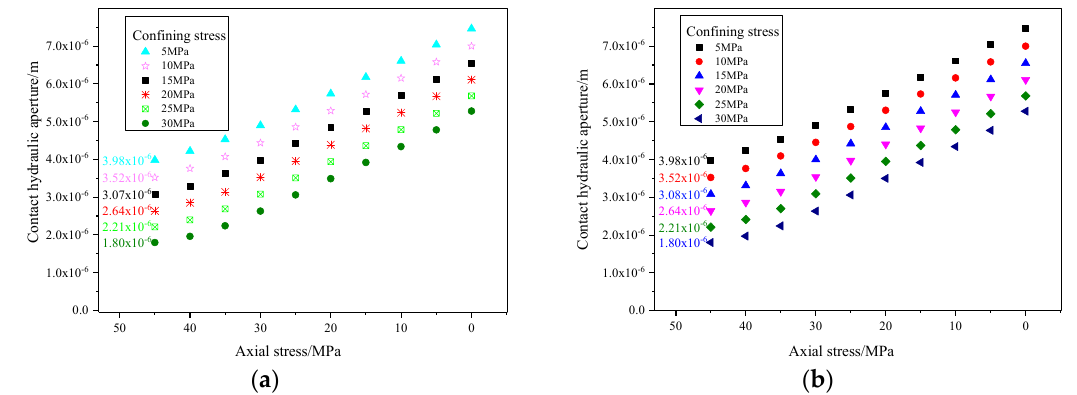
Figure 23. Change curve of the average joint hydraulic aperture value: ( a ) 60-degree crack angle and ( b ) 70 degree crack angle.